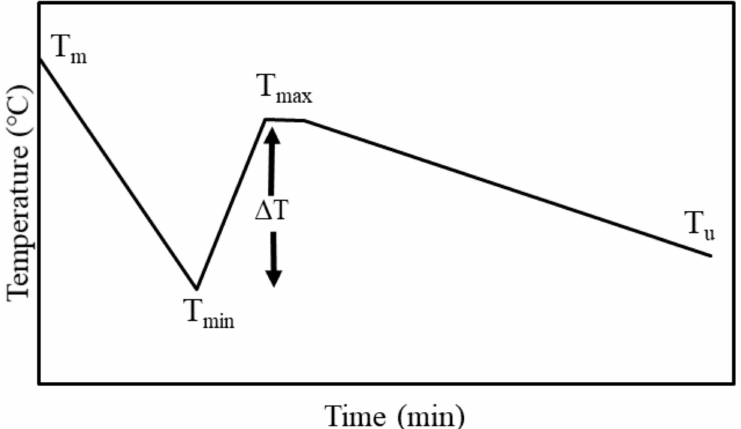
Figure 5. Thermal schedule used to generate the thermal condition of the billet surface in the continuous casting process: T m is melting point, T min and T max are lowest and highest temperatures respectively. T u is the temperature at the straightener and ∆ T is the undercooling step